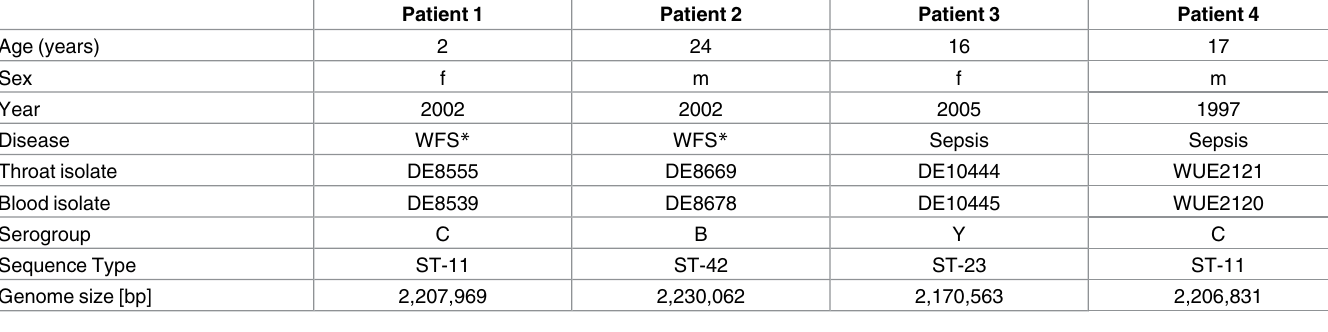
Table 1. Overview over the patient and the respective